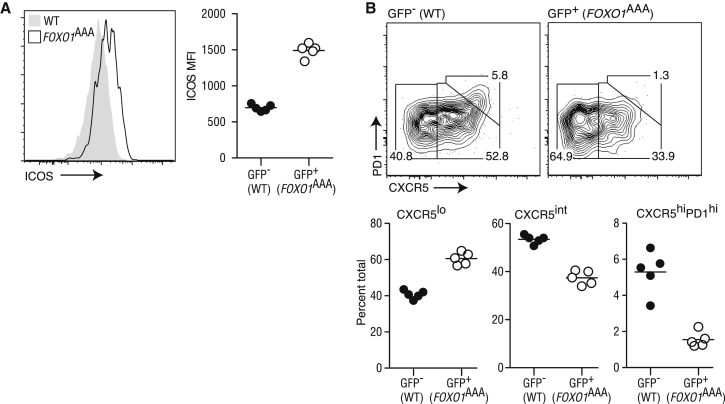
Enforced Nuclear Localization of FOXO1 Suppresses Tfh Differentiation(A) ICOS expression or (B) the percentages of CXCR5lo, CXCR5int, and CXCR5hiPD1+ cells from WT or Foxo1AAA OTII cells day 4 post immunization. In each case, p < 0.001. Data are representative of two independent experiments.